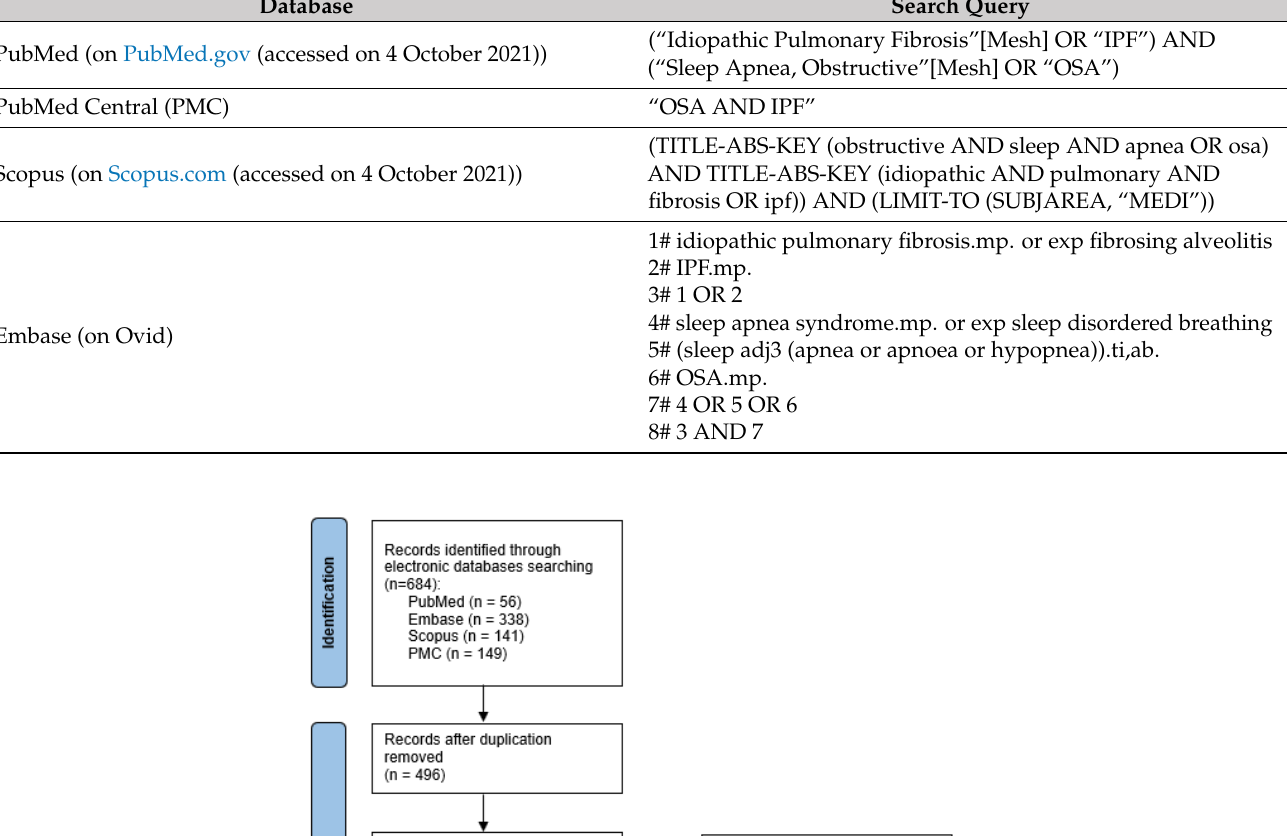
Table 1. Detailed search strategy for primary literature search. IPF, idiopathic pulmonary fibrosis; OSA, obstructive sleep apnea.